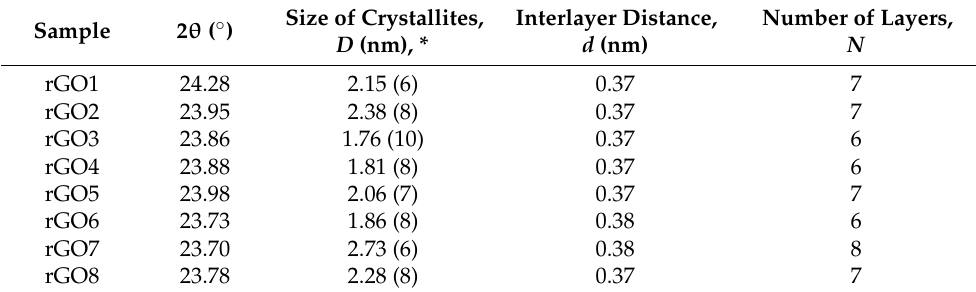
Table 4. Data obtained from X-ray examinations of the size of crystallites, the number of graphene layers in rGO, as well as the distance between